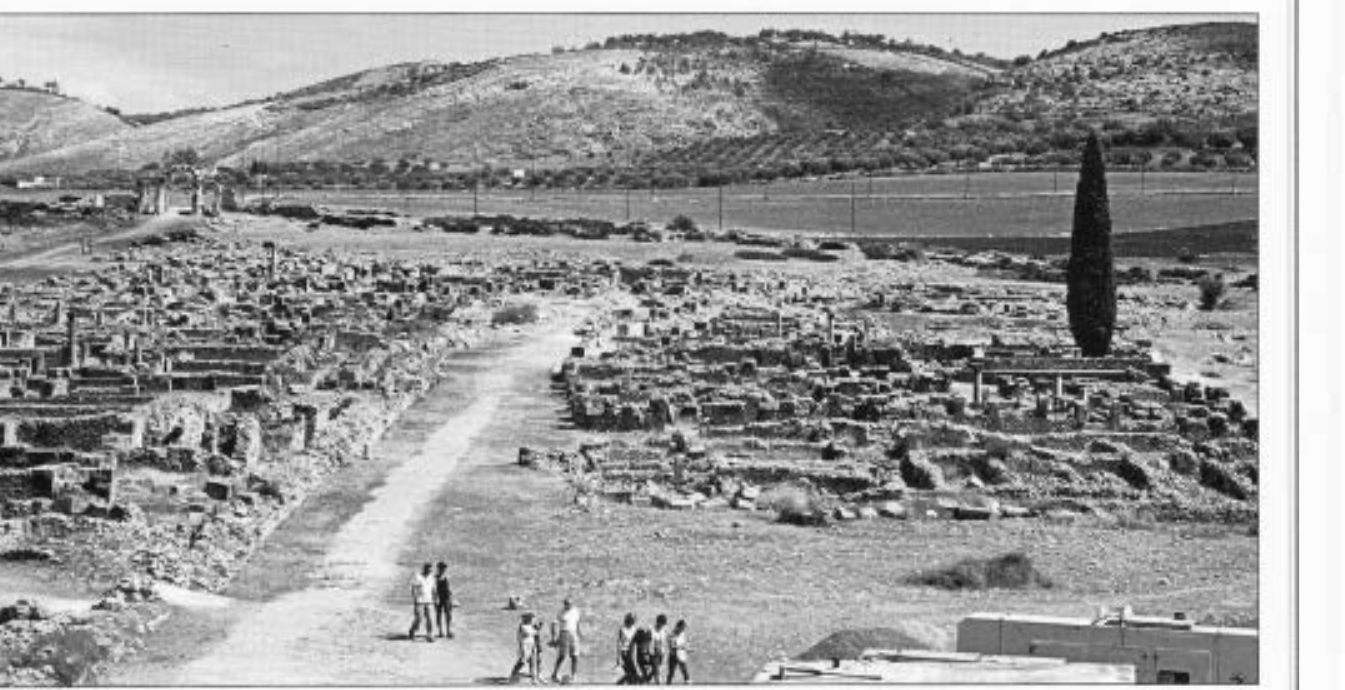
Figure 1 Northwest Africa, showing the location of Volubilis and other ancient sites mentioned in the text.